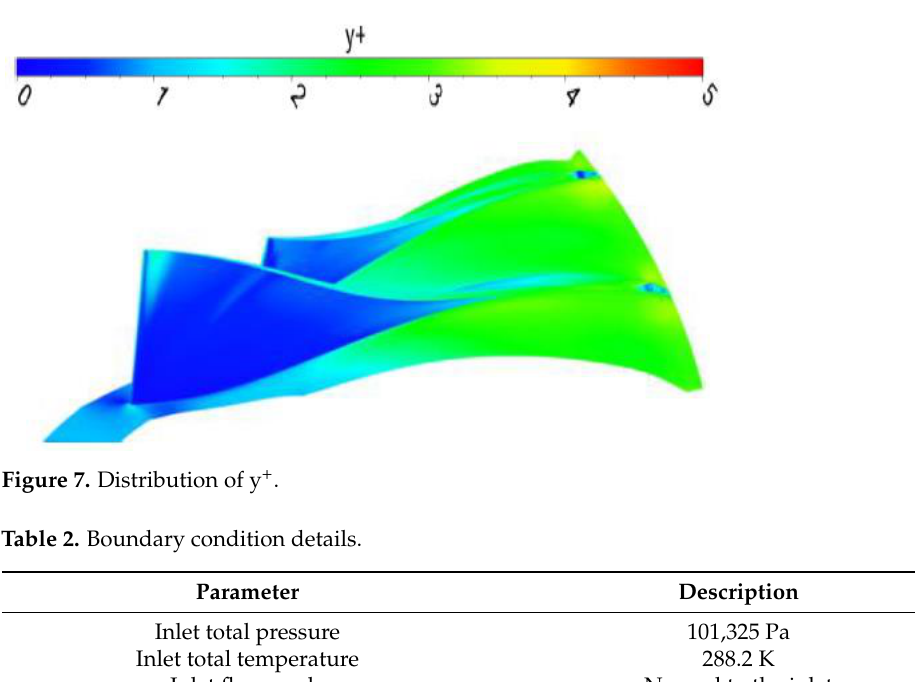
Table 2. Boundary condition details.